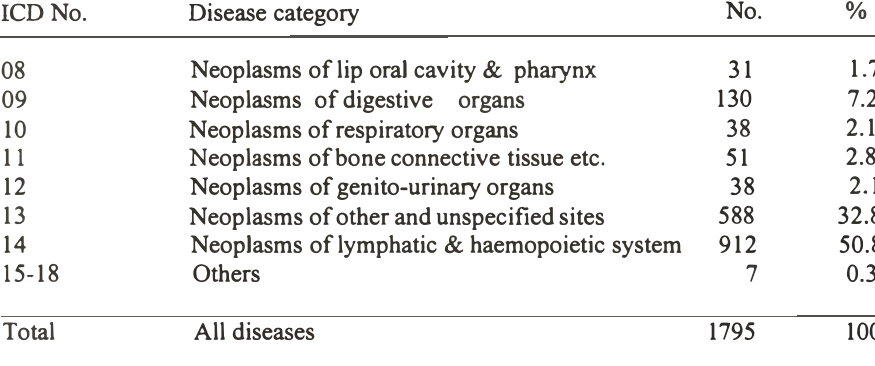
Table l 0: Distribution of deaths by broad disease categories